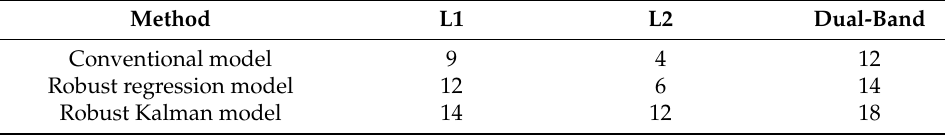
Table 2. Number of effective satellites used phase on each band.